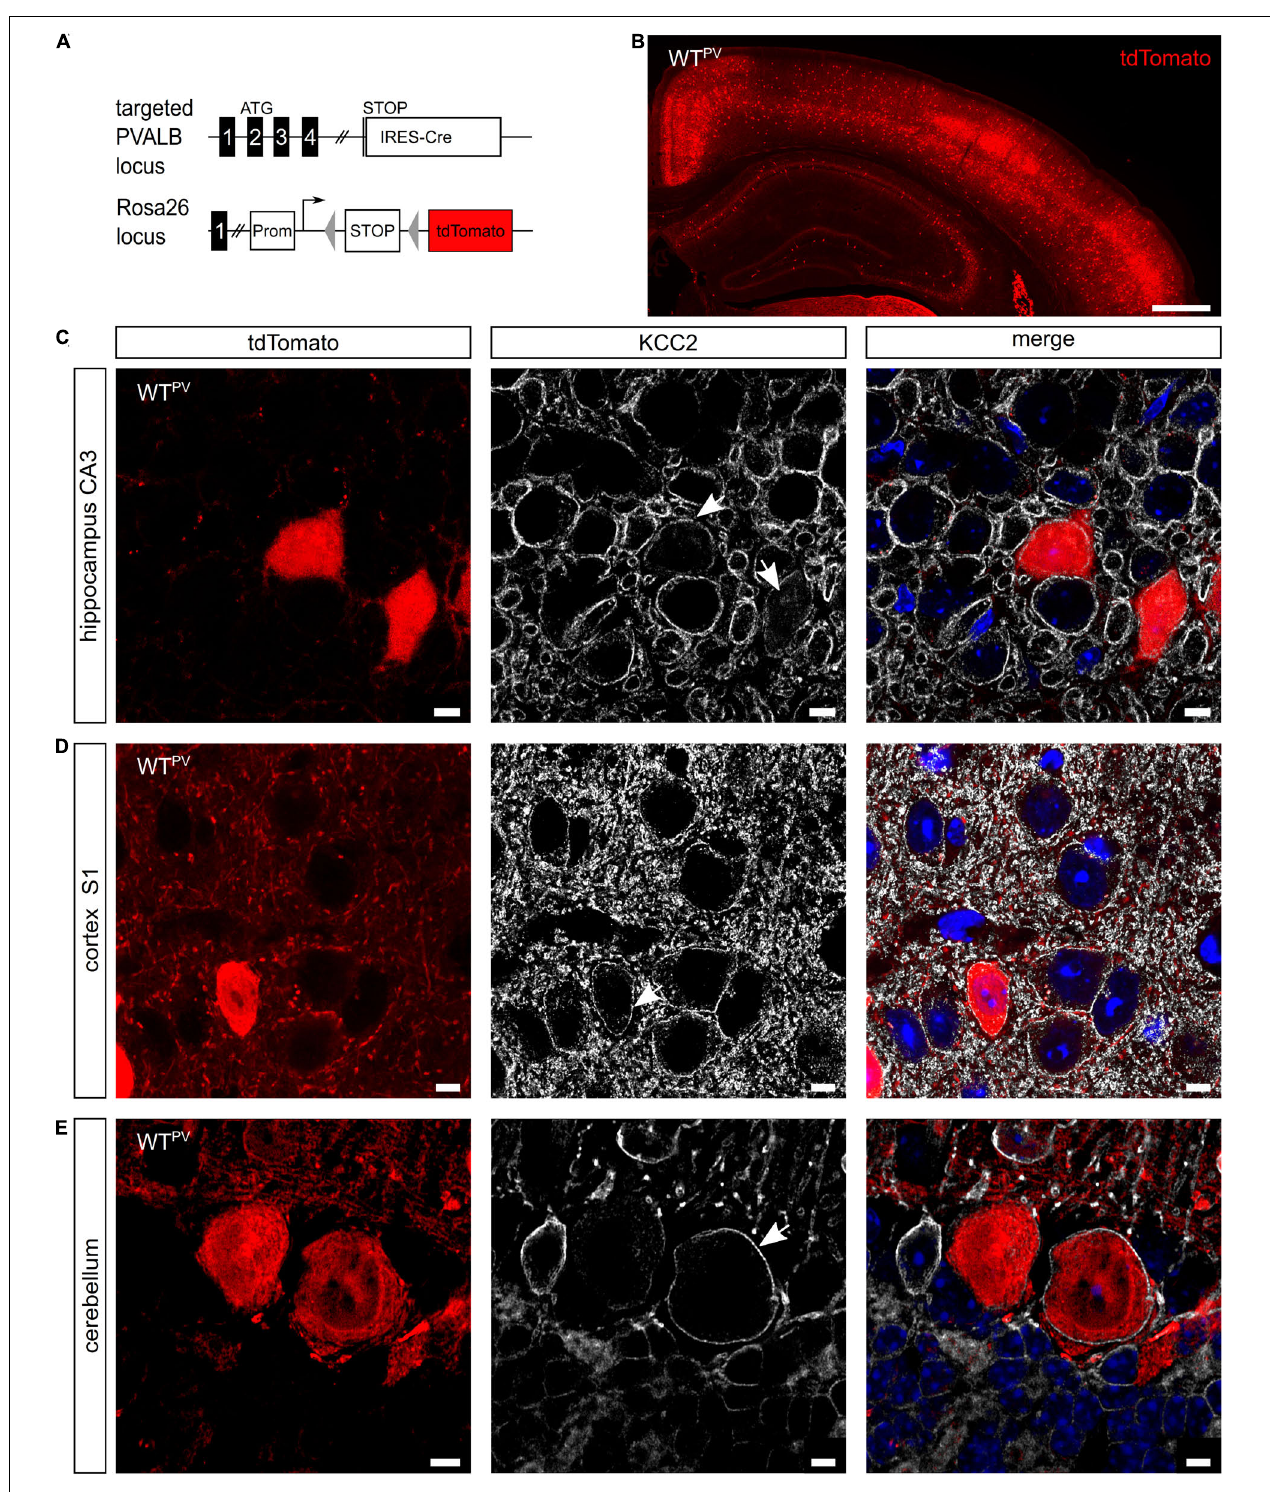
FIGURE 1 | KCC2 is broadly expressed in PV-INs. (A) To label PV-INs we mated a mouse line expressing Cre-recombinase under the control of the PV promoter (PV-Cre) (Hippenmeyer et al., 2005) with a tdTomato reporter line (Madisen et al., 2010). Cre-mediated excision of the STOP cassette results in the expression of tdTomato. (B) Coronal section of the cortex and the hippocampus of an 8-week-old mouse transgenic for Cre-recombinase and the tdTomato allele (WT PV ). Scale bars 500 µ m. (C–E) Brain sections from WT PV mice were stained for KCC2. tdTomato-positive neurons in the hippocampus (C) , somatosensory cortex (D) , and cerebellum (E) displayed a clear KCC2 signal at the plasma membrane (arrows). Nuclei were counterstained with DAPI. Scale bars 10 µ m.